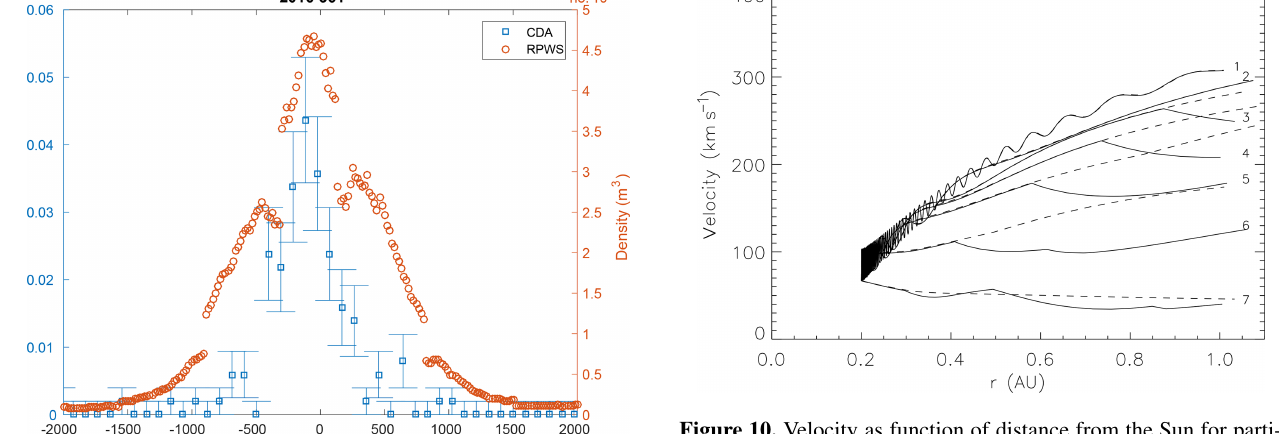
Figure 10. Velocity as function of distance from the Sun for parti- cles with Q/m = 10 − 4 , 10 − 5 , 10 − 6 and 10 − 7 e/m p released from a circular orbit with the radius 0.2AU near the ecliptic plane. Solid lines correspond to the focusing, and dashed to defocusing, mag- netic field orientation (adapted from Mann et al.,